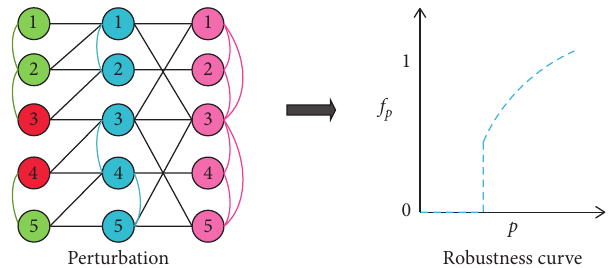
Figure 1: An illustration to the common idea shared by most existing metrics for quantifying the robustness of a networked system under node metrics have been proposed by researchers, and most of them share the common idea as delineated in Figure 1.